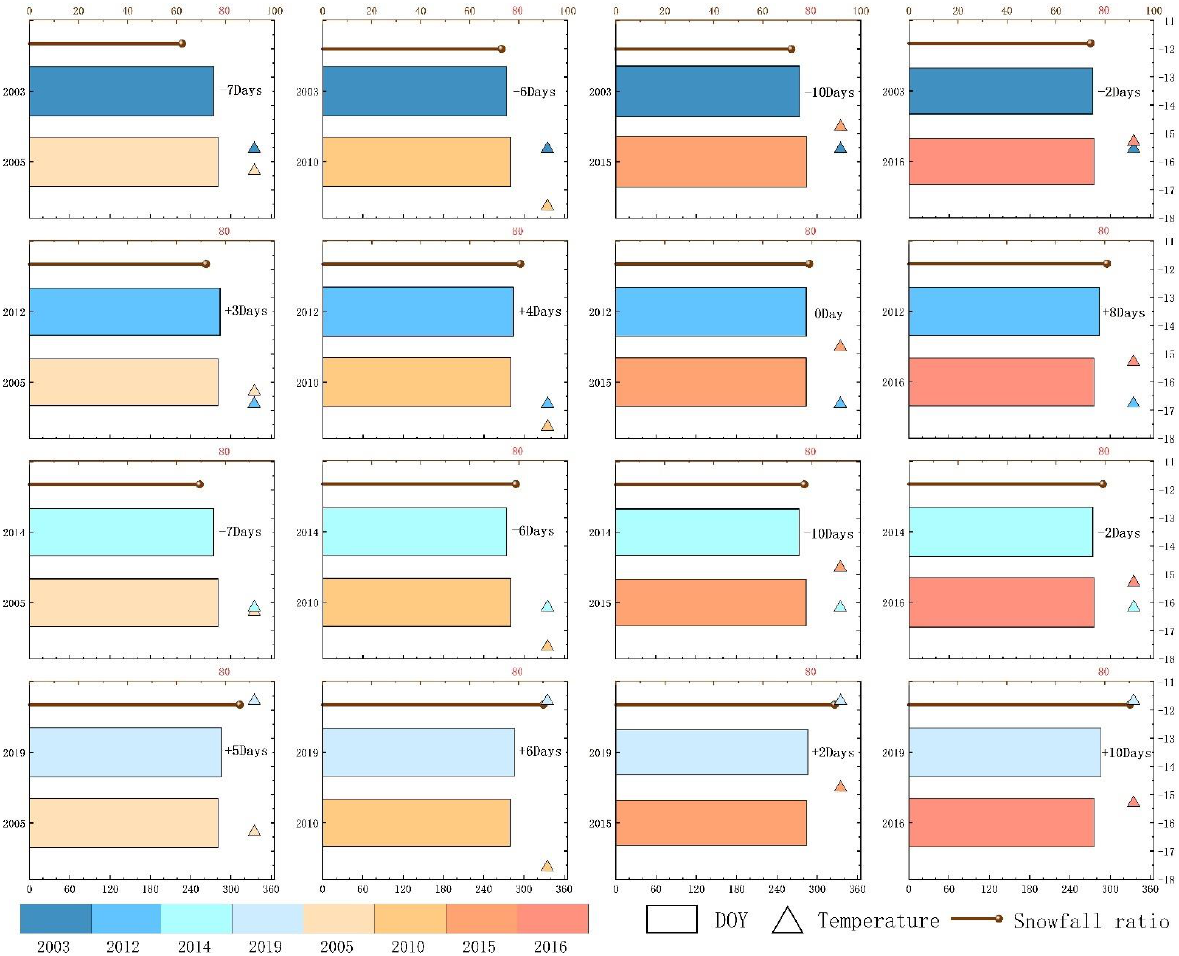
Figure 8. The grassland EOS by year of date in the Sanjiang Plain. The left axis is the year, the right axis is the temperature ( ◦ C), the upper axis is the snowfall ratio, and the lower axis is the DOY of each year’s EOS. Rectangles represent the DOY of SOS, triangles represent the temperature, and lines represent the snowfall ratio.